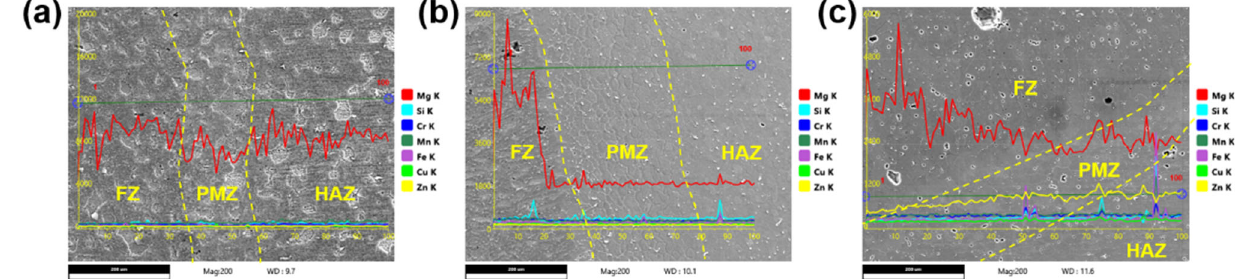
Figure 5. Energy-dispersive X-ray spectroscopy (EDS) scanning results of different aluminum alloy welded joints: ( a ) 5083; ( b ) 6005A; ( c ) 7N01.